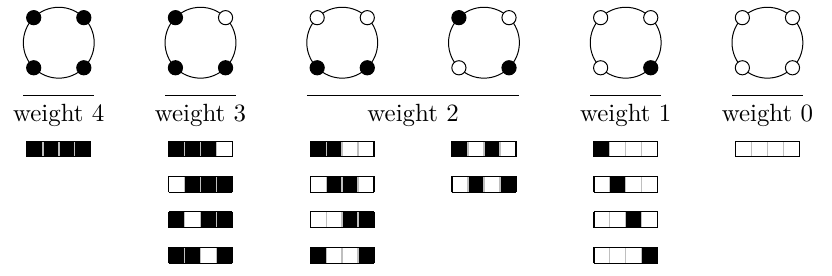
Figure 4: Necklaces with n = 4 beads in 2 colors, each corresponding to up to n equivalent patterns of active S-boxes for n -bit words; fewer in case of rotation-symmetric patterns.